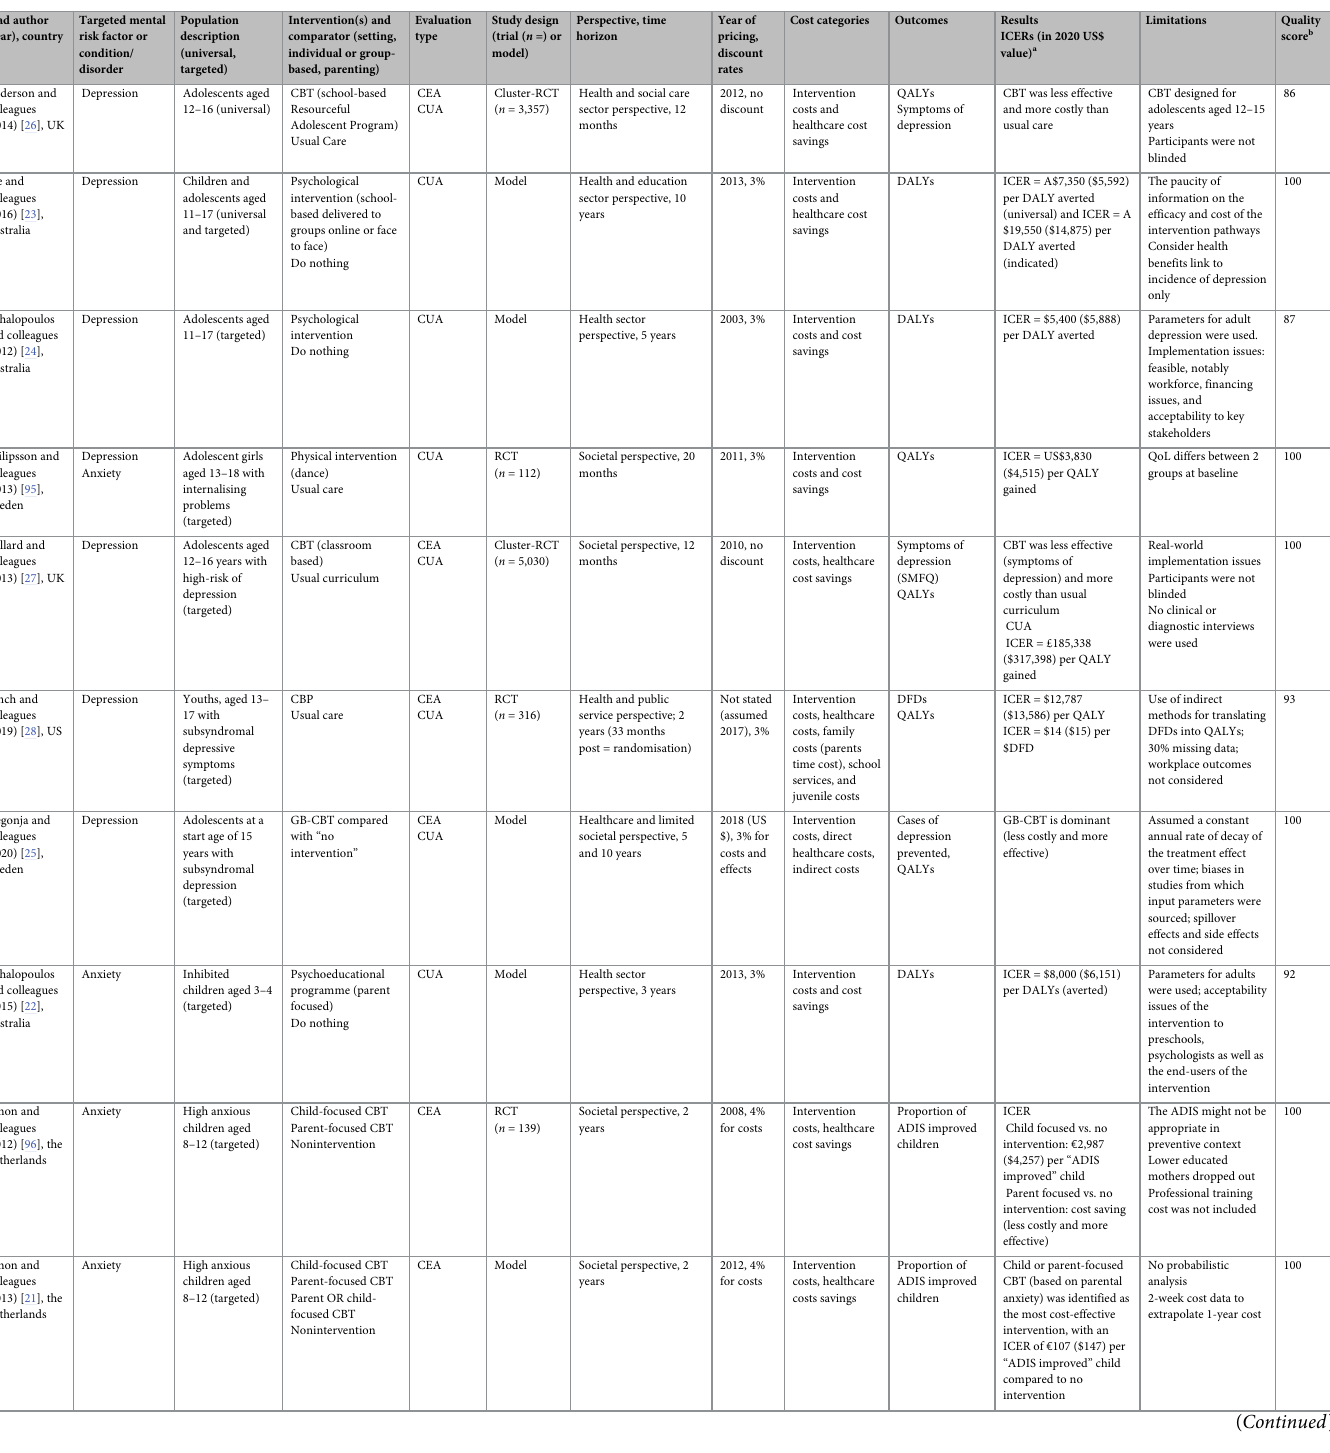
Table 1. Characteristics of studies included—children and adolescents. AU : PleasecheckandconfirmifTables 1 (cid:0) 3 arepresentedcorrectly = accurately : Leadauthor Targetedmental (year),country riskfactoror